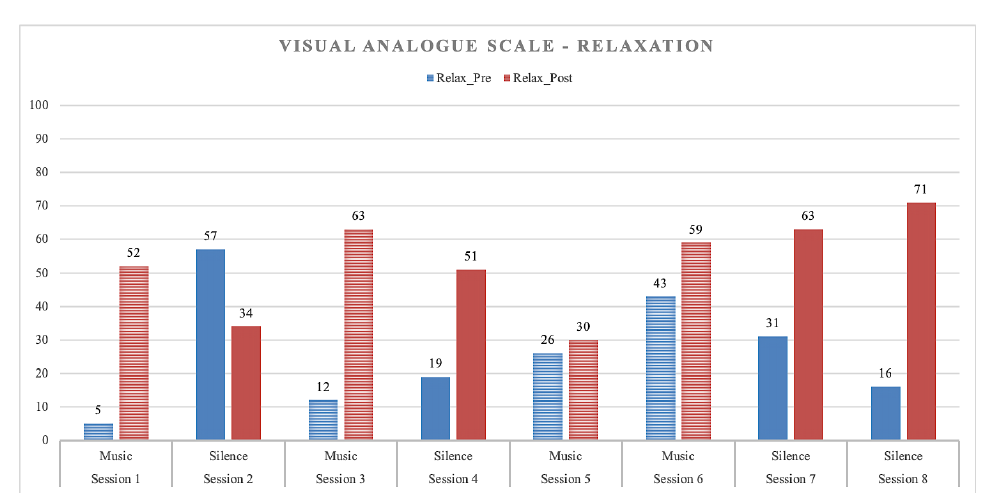
FFigigururee 55 Pre- and post-treatment scores for relaxation completed before and after each treatment in all sessions. Solid colours represent VA-Silence sessions. Visual Analogue Scales range from 0 (tense) to 100 (relaxed). Point increase (+) relates to greater